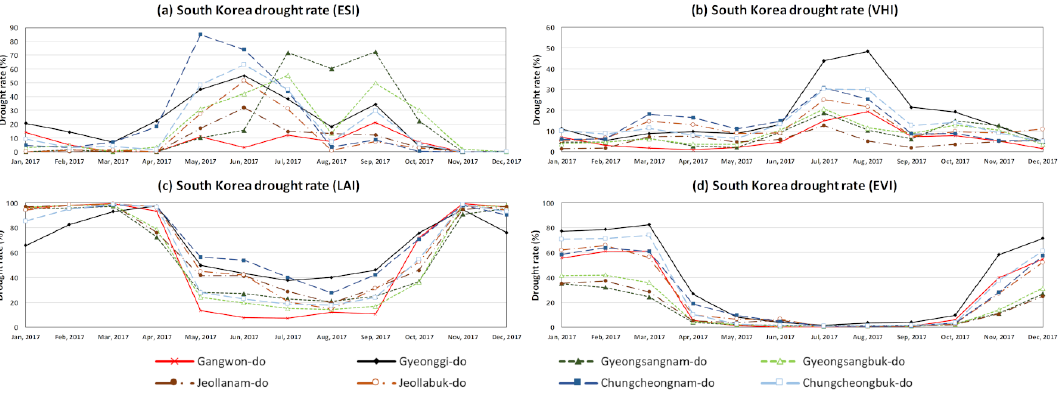
Figure 4. Temporal changes in drought area ratios of total area in each district as determined by the ( a ) ESI, ( b ) VHI, ( c ) LAI, and ( d ) EVI values for the eight provinces in South Korea during the 2017 drought.